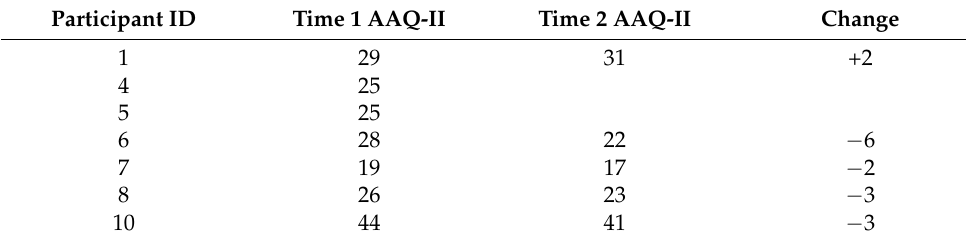
Table 5. Participant AAQ-II scores at times one and